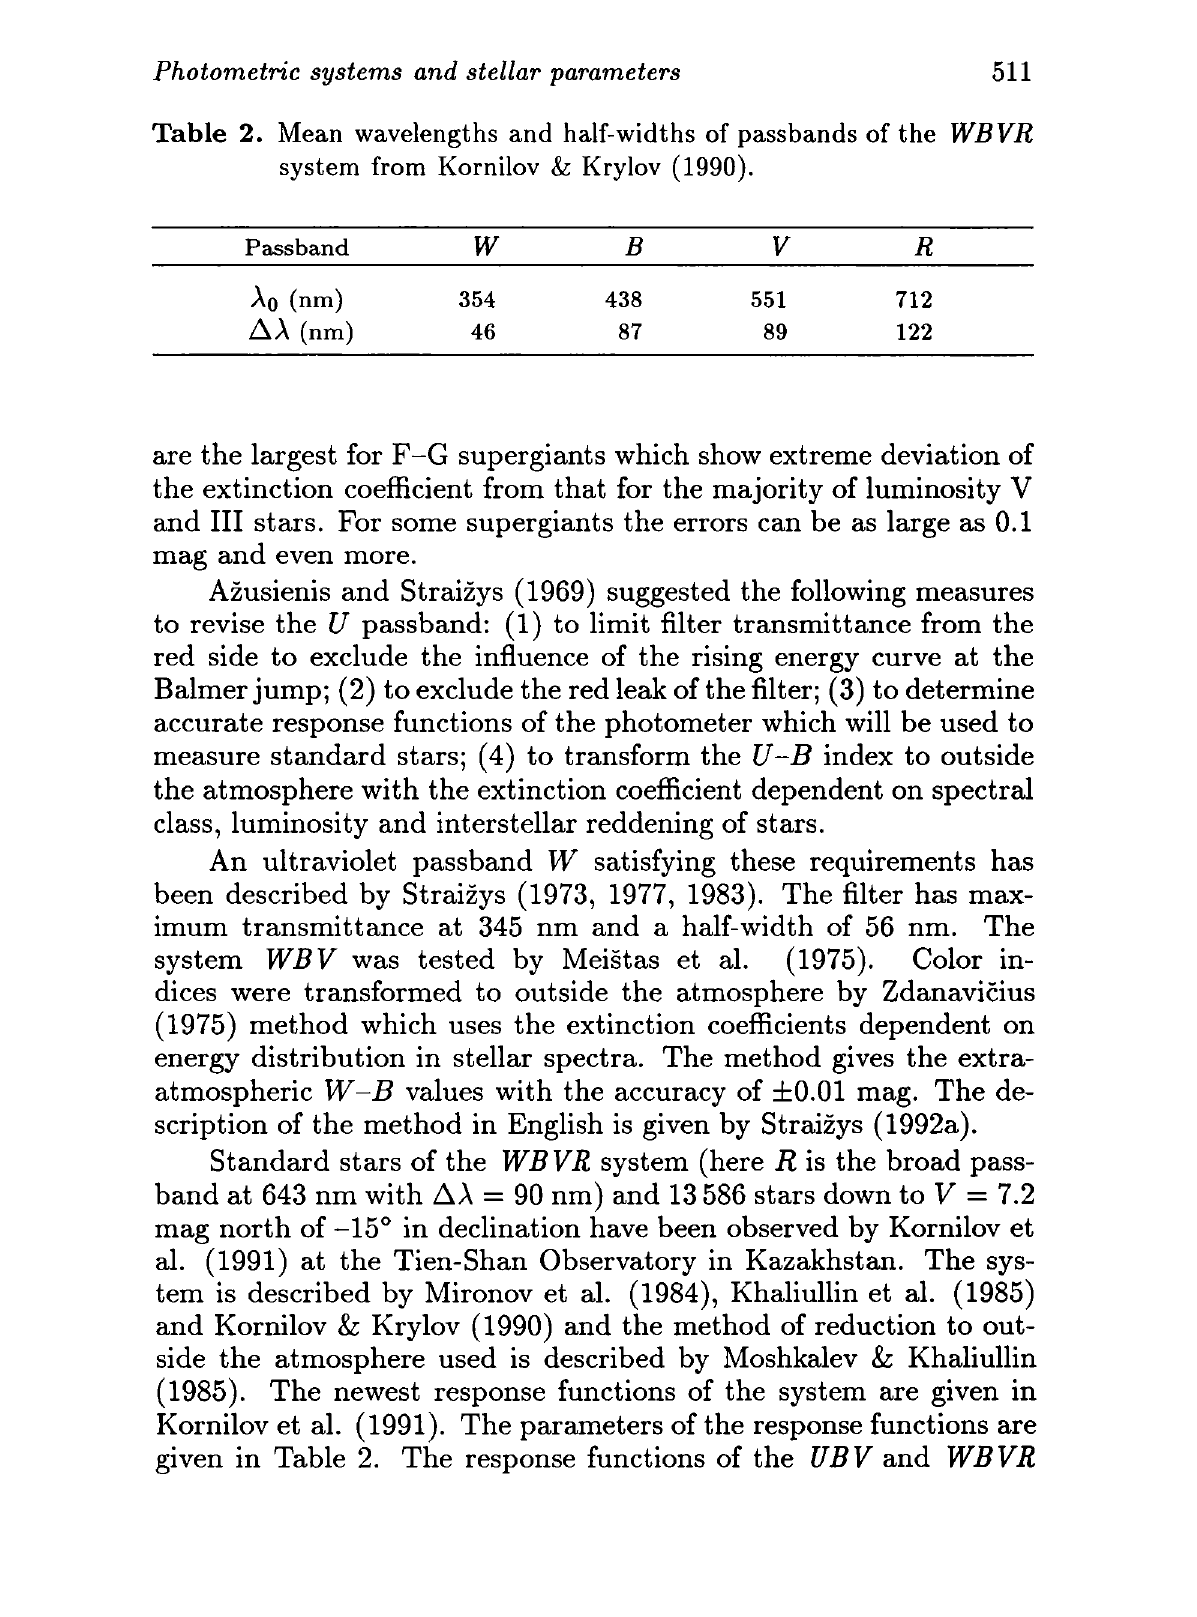
Table 2. Mean wavelengths and half-widths of passbands of the WBVR system from Kornilov & Krylov